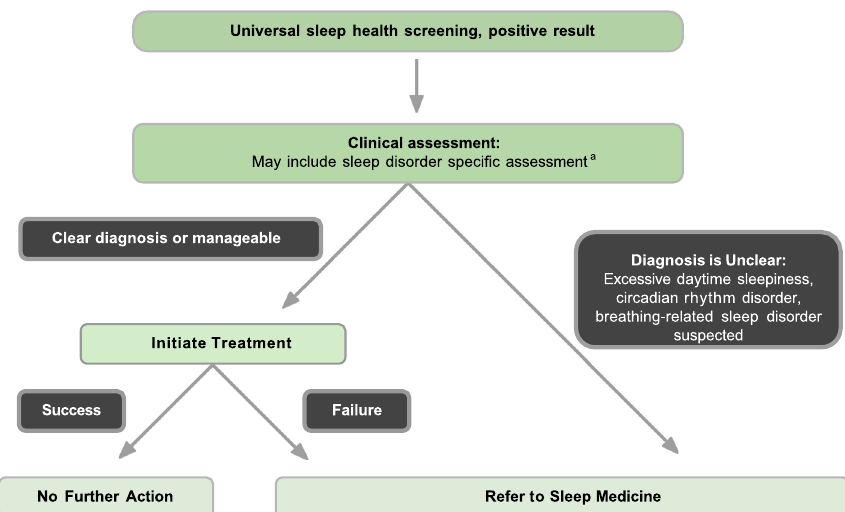
Fig. 1 Sleep Health Triage. a See text for suggested sleep disorder-specific scales that may be used to assess for specific sleep disorders if initial screening is